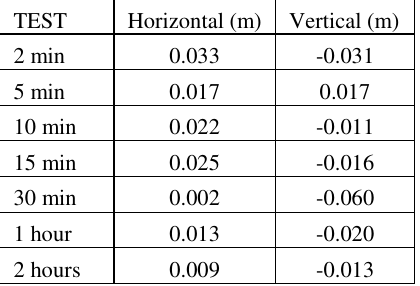
Table 2. Deviations in horizontal and vertical for TEST.